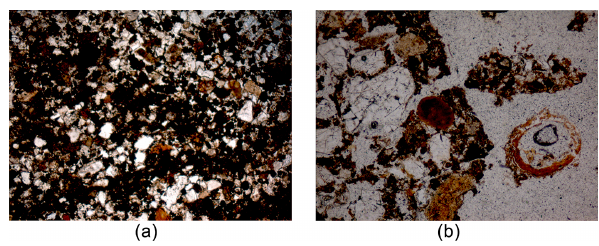
Figure 5. (a) Humons (organic particles with non-humified organic matter), transmitted light; (b) organic tissue of non-decomposed